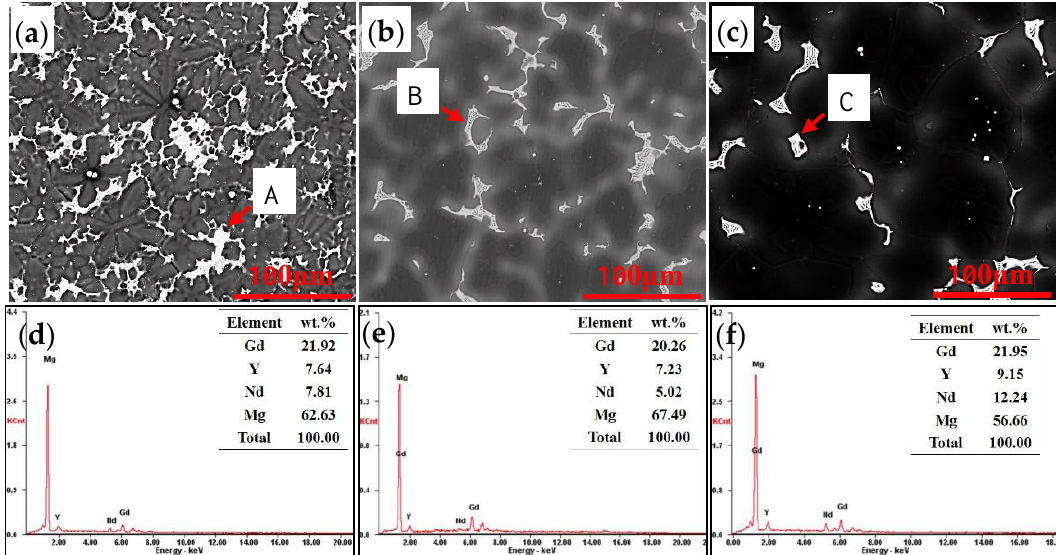
Figure 2. Scanning electron microscopy (SEM) images and energy dispersive spectrometry (EDS) results of alloys with different Gd and Y contents: ( a ) SEM image of alloy A ( b ) SEM image of alloy B ( c ) SEM image of alloy C ( d ) EDS results of particle A( e ) EDS results of particle B ( f ) EDS results of particle C.